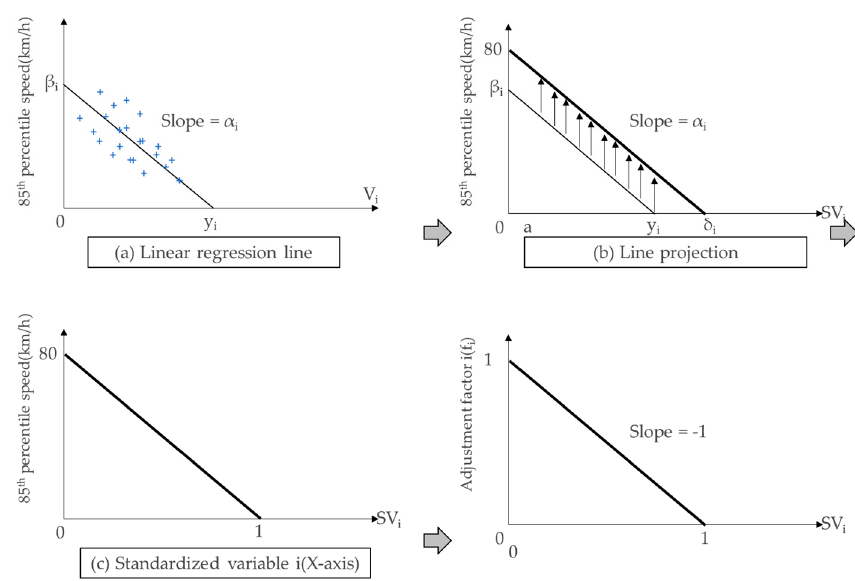
Figure 9. Plots illustrating the standardization procedure.